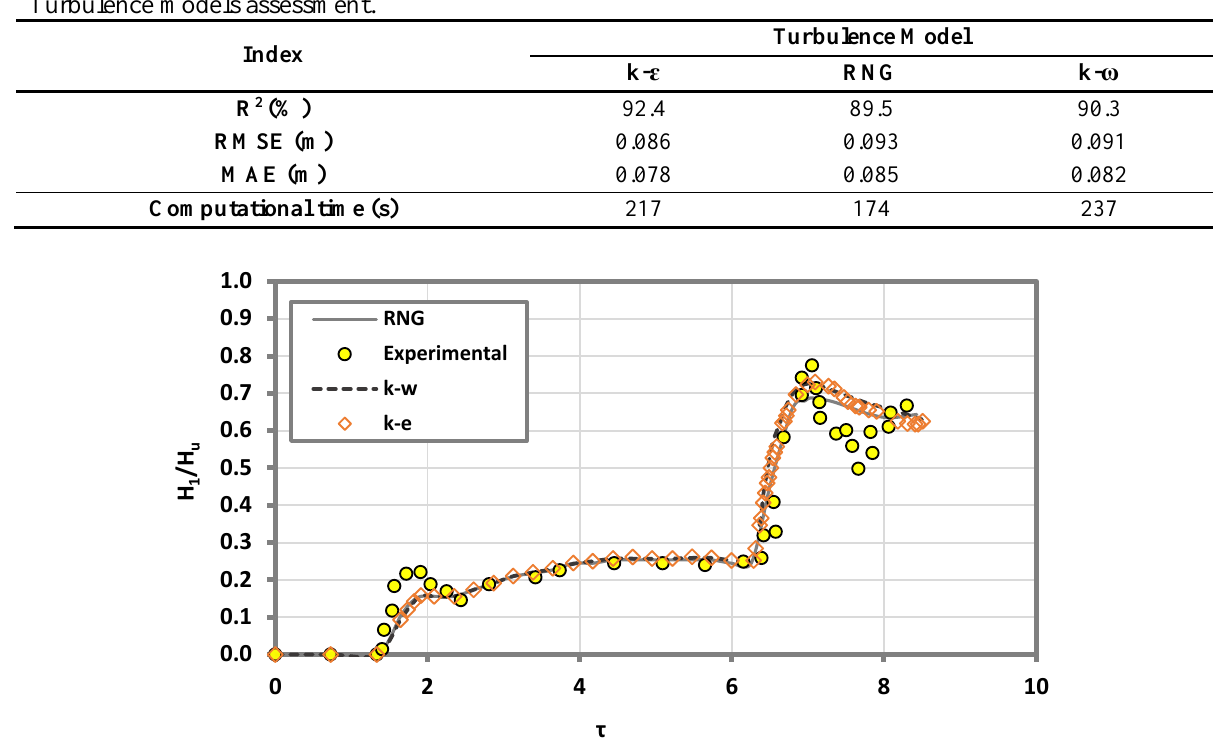
Fig. 5. Comparison of three turbulence models performance to simulate water level at 2.228